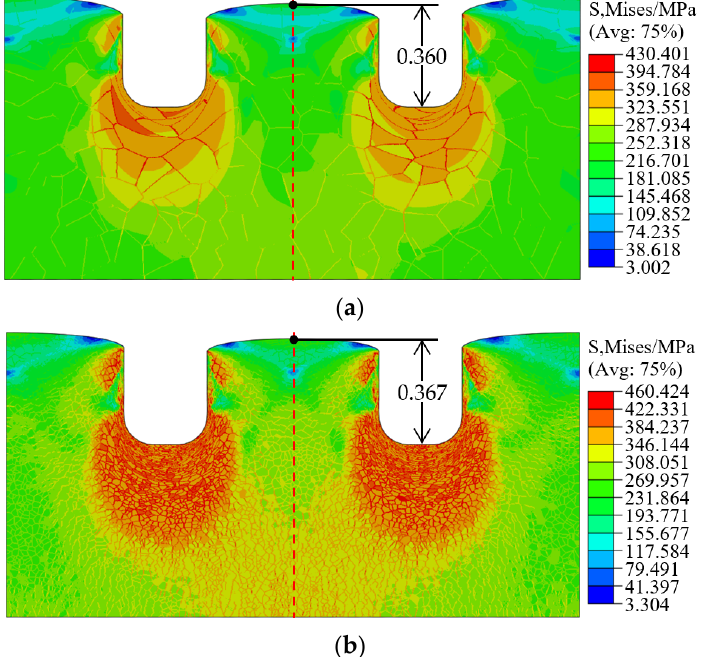
Figure 17. Mises stress distribution and filling height after micro ‐ filling simulation: ( a ) CG model; ( b ) FG model.